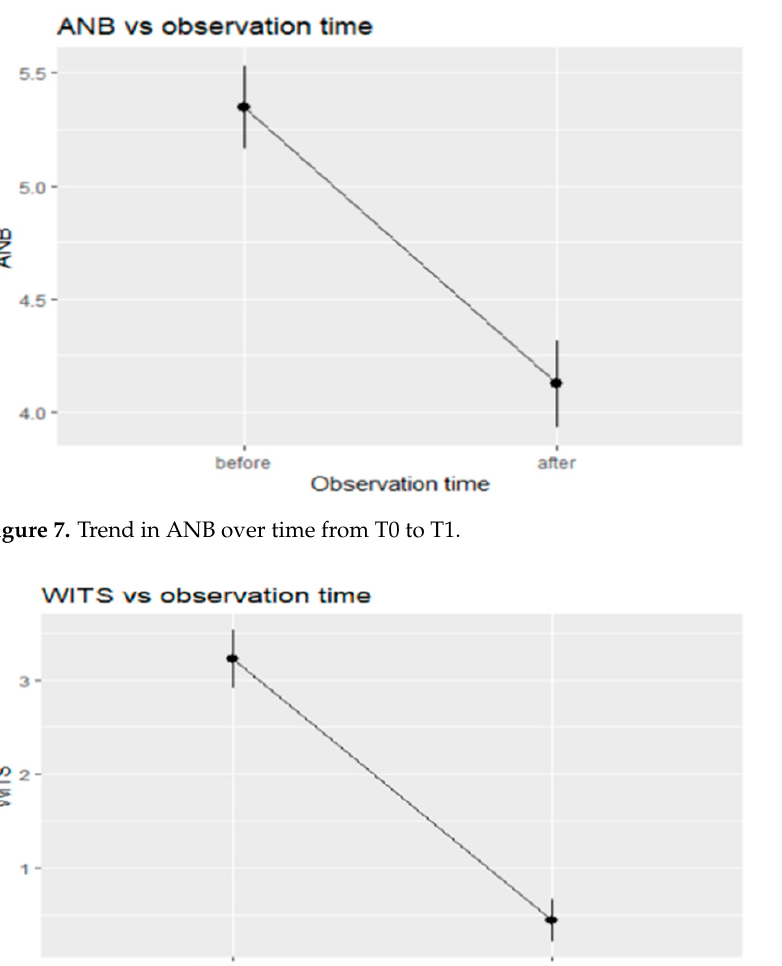
Figure 9. Trend in MP-SN over time from T0 to T1.